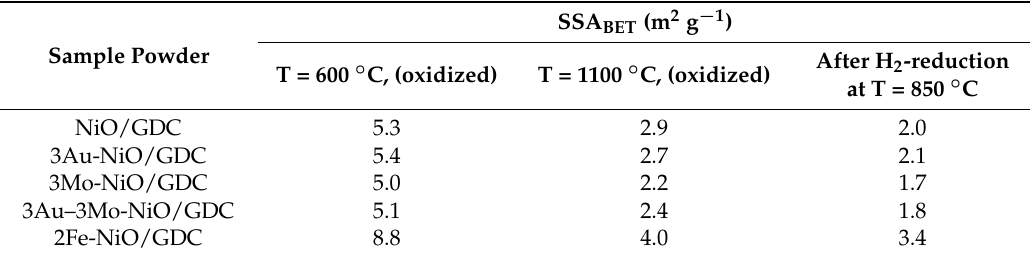
Table 1. BET Specific Surface Area (SSA BET ) of commercial NiO/GDC, and X-modified